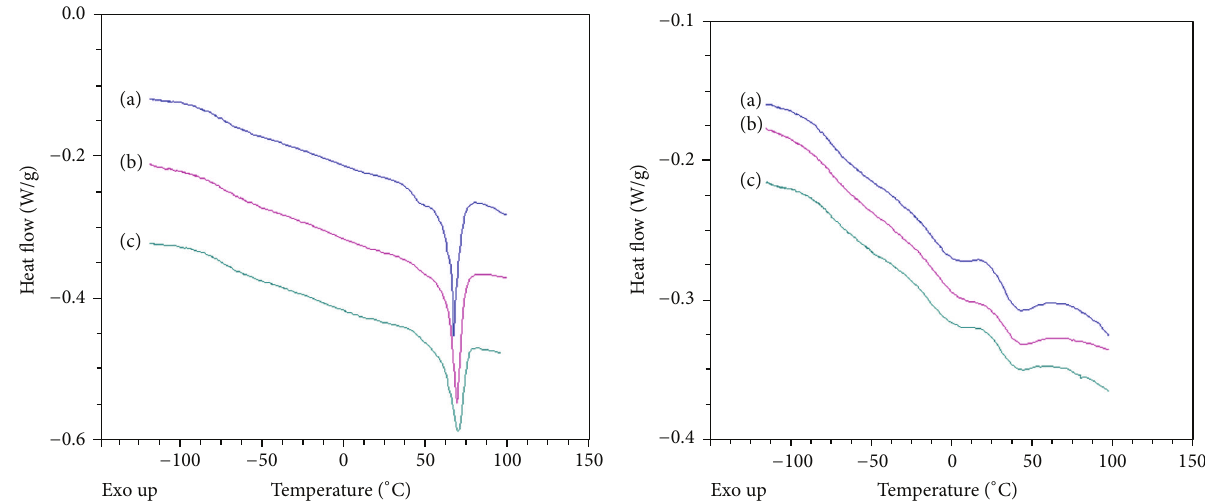
Figure 2: DSC thermograms of the first (left) and second (right) scans for 5% of gelatin nanocomposites with 0% (a), 5% (b), and 10% (c) of MMT and stored at 58% of